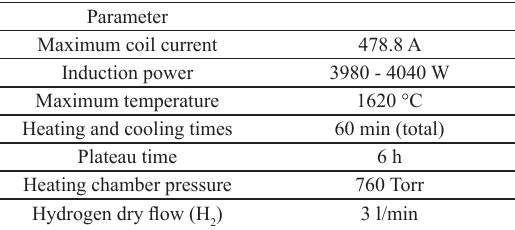
Table 2. Improved parameters for the tungsten cathode matrix decopperization step.